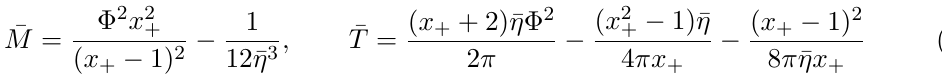
Figure 10 . Thermodynamic potential vs temperature, at (cid:12)xed (cid:22) P = 0 : 01. The swallowtail develops when (cid:8) increases, from below, to 1 = included in the